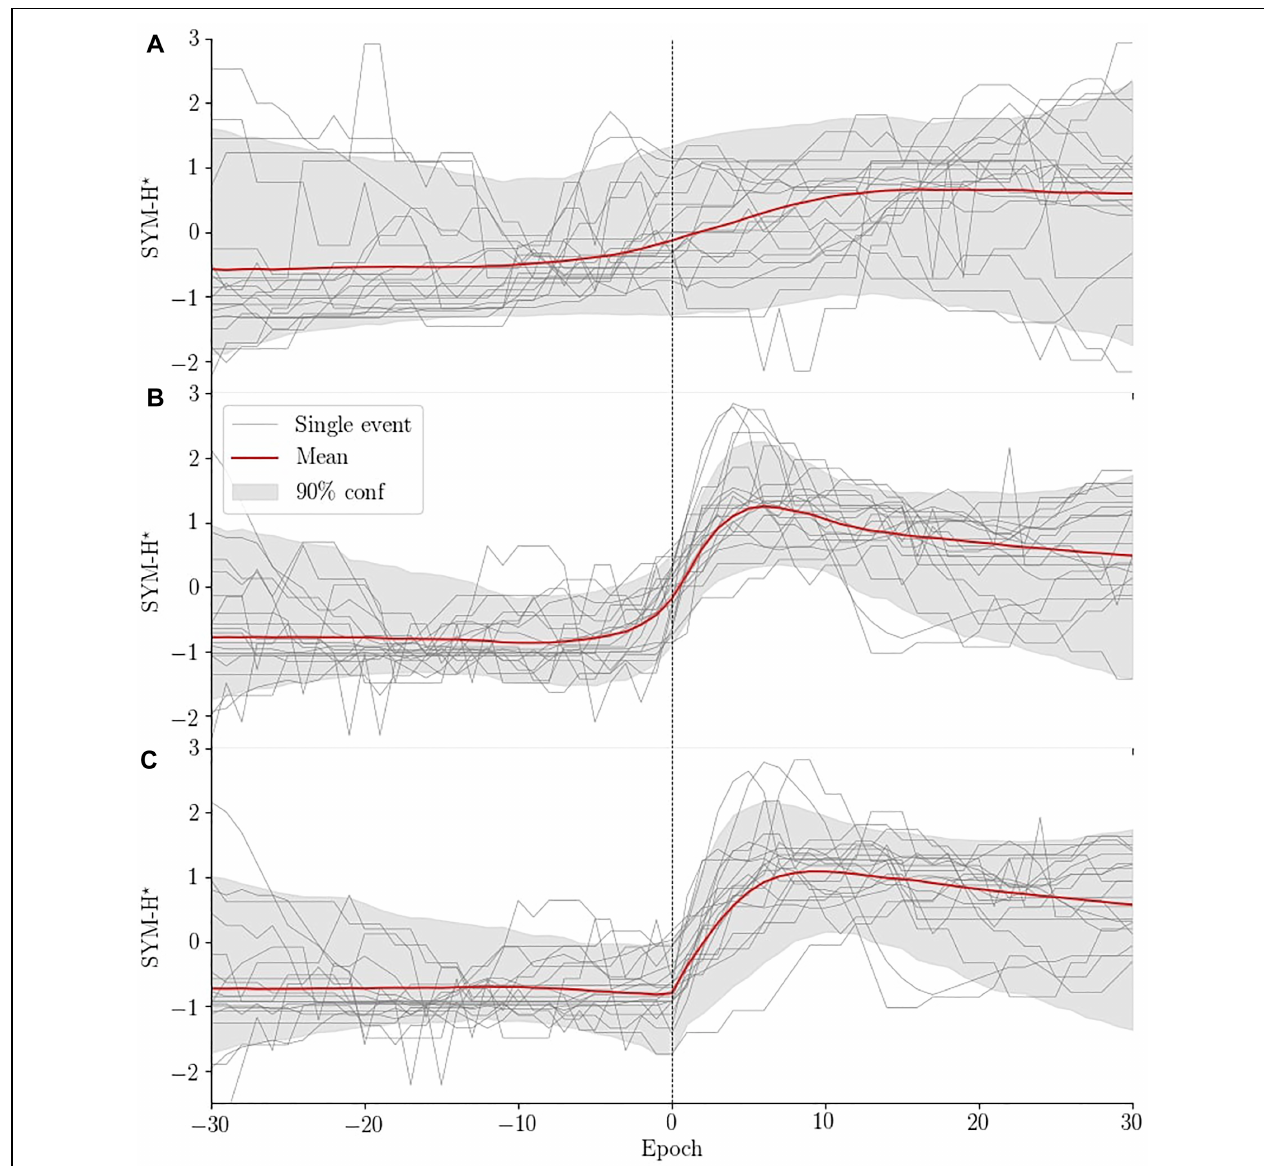
FIGURE 5 | Comparison of normalized superposed SYM-H before any arrival time correction (A) , after correlation analysis (B) and after aligning the onset of the SYM-H response (C) . The shaded area illustrates the 90% confidence interval, the grey lines are 20 randomly selected events and the red lines are the mean of the distribution. Each event has been normalized, indicated by the asterisk in the axis label, in order to improve comparison between events.